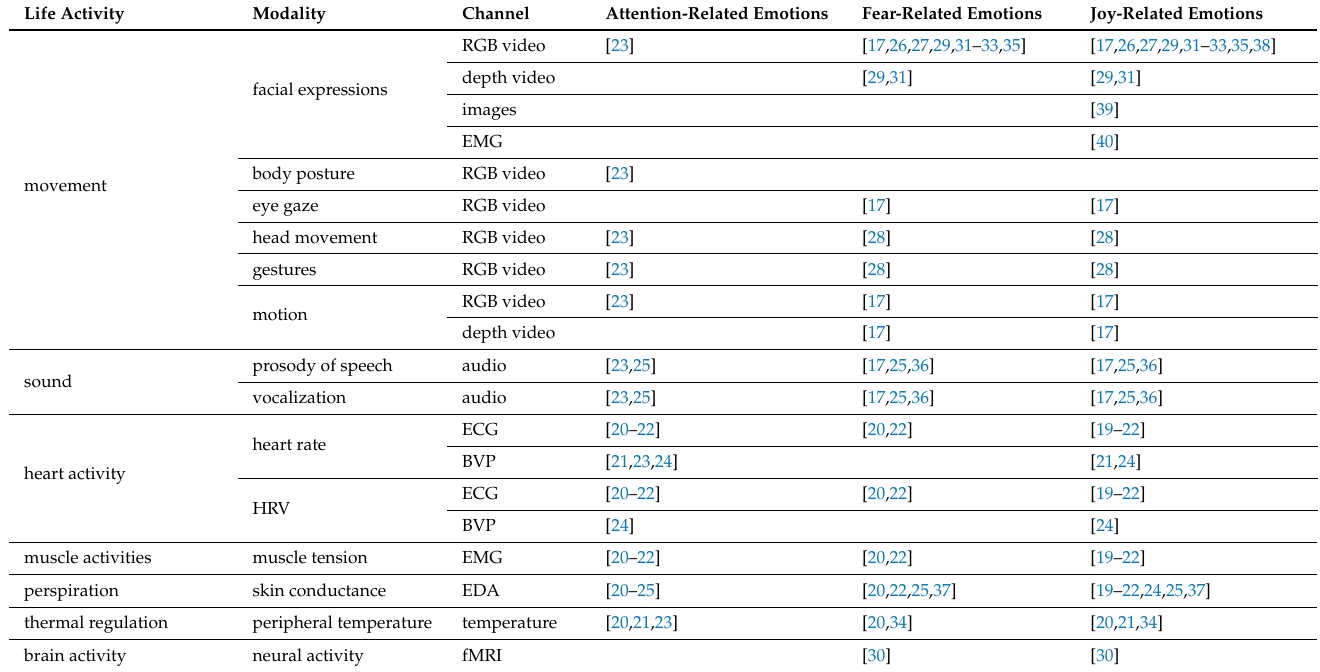
Table 7. Identified groups of emotions corresponding to channels used in the process of emo- tion